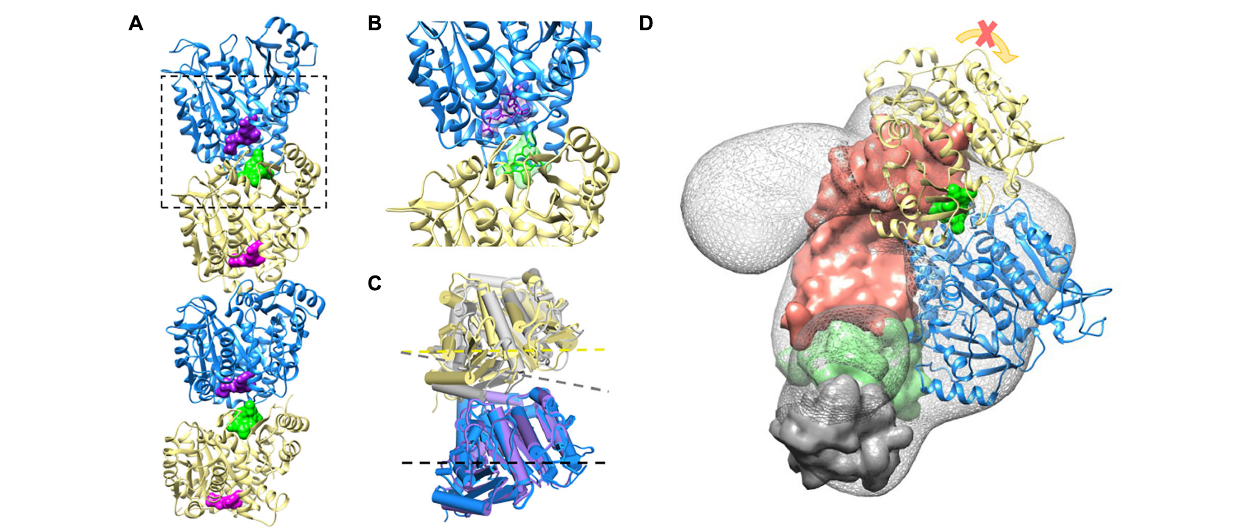
FIGURE 4 | Colchicine could impair TBCE-TBCB complex function in the α / β -tubulin heterodimer dissociation process by stabilizing the α -tubulin/ β -tubulin interface. (A) Two associated α / β -tubulin heterodimers stabilized by the colchicine molecule (green surface). The GTP form of the α -tubulin monomer and the GDP form of the β -tubulin are displayed in blue and yellow (GTP and GDP surfaces are shown in purple and magenta, respectively), PDB ID 4O2B. (B) Zoom-in view of colchicine (green) at the α / β -tubulin interface, next to the α -tubulin GTP binding pocket, PDB ID 4O2B (Prota et al., 2014). (C) Comparison of the free α / β -tubulin heterodimer ( α -tubulin in purple and β -tubulin in gray, PDB ID 1JFF; Löwe et al., 2001), with the α / β -tubulin heterodimer stabilized by colchicine ( α -tubulin in blue and β -tubulin in yellow, PDB ID 4O2B; Prota et al., 2014) by aligning the α -tubulin monomers. The presence of colchicine affects the α / β -tubulin interface geometry, as shown with the dash lines. (D) The complex TBCE-TBCB, hold by the interaction between the CAP-Gly domains (TBCE CAP-Gly domain surface in green and TBCB CAP-Gly domain surface in gray), binds the α -tubulin monomer of the α / β -tubulin heterodimer (blue, EMDB-2447; Serna et al., 2015) pushing the TBCE LRR domain (domain surface in coral) toward the β -tubulin monomer (yellow) and distorting the α / β -tubulin interface. The presence of colchicine (green surface) could impair α / β -tubulin heterodimer dissociation by stabilizing the α / β -tubulin interface, making it resistant to the mechanical force applied by the LRR